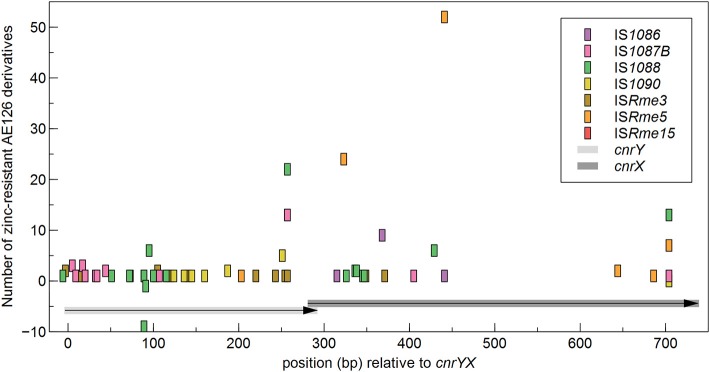
Distribution of IS elements in the cnrYX locus of zinc-resistant AE126 derivatives. Insertions in the same and opposite transcriptional orientation as the cnr operon are shown as positive and negative values, respectively.